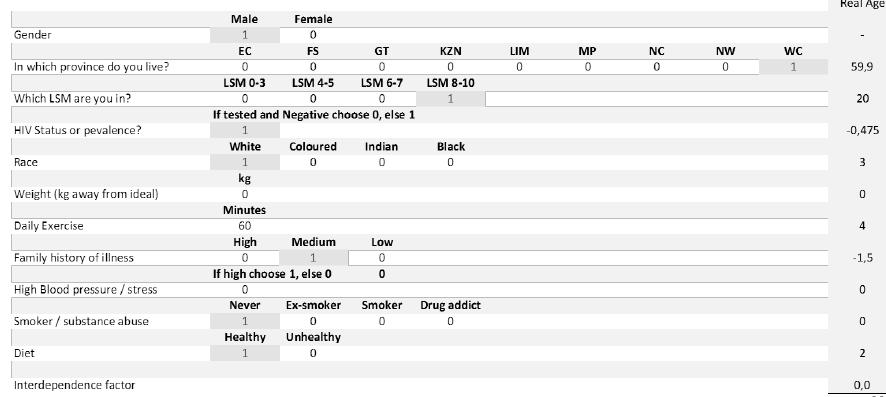
FIGURE 6: Graphical interface showing simulation of Person_X Source: Created by